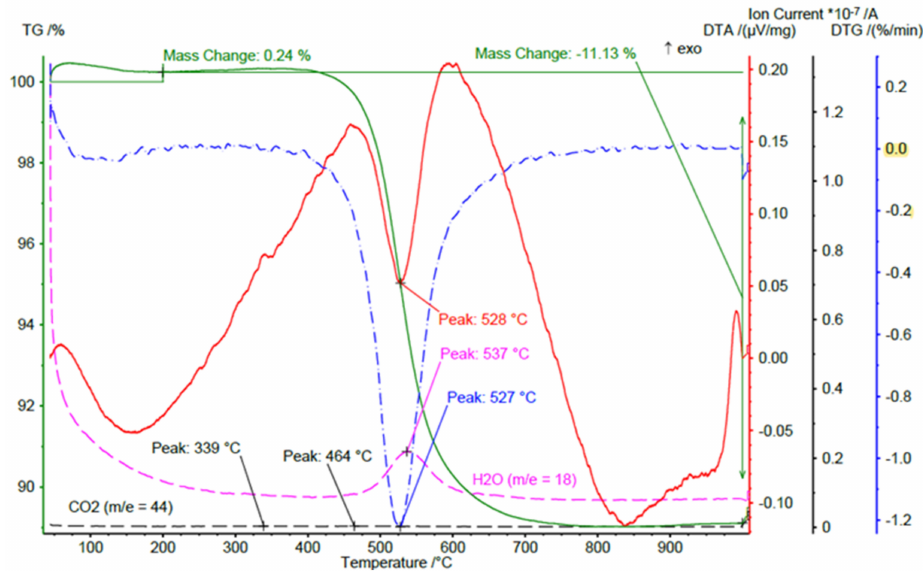
Figure 4. DTA, DTG, and TG analysis of kaolin clay